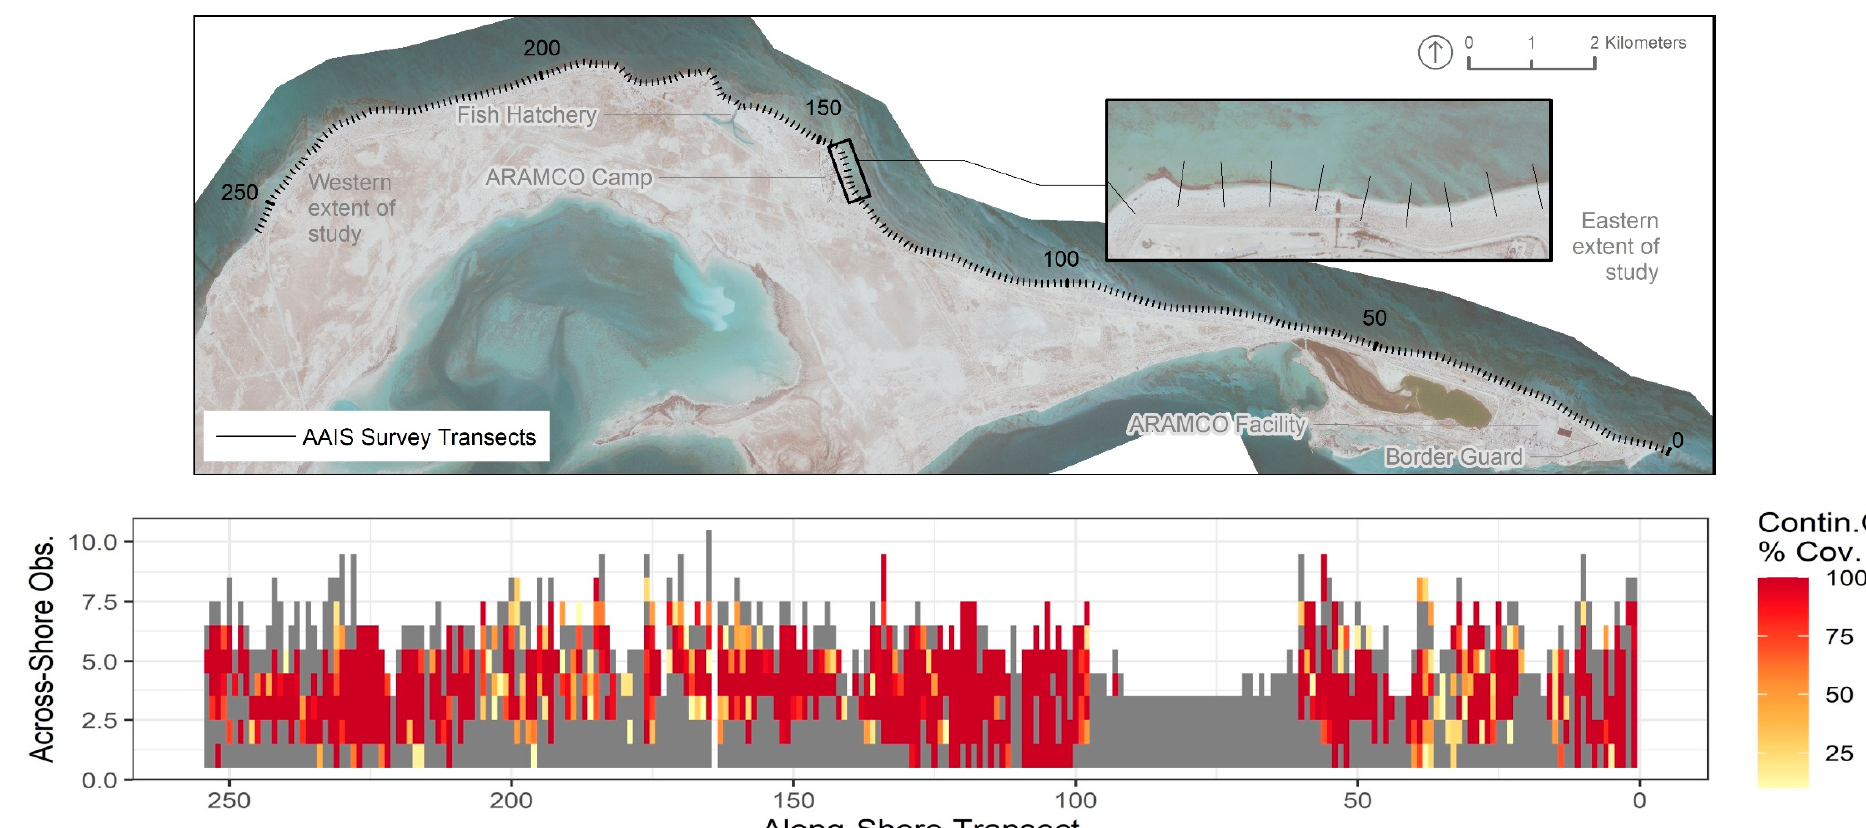
Figure 5. Across-shore tile charts depicting percent cover of continuous asphalt pavements or heavily oiled sediment layers oiling at each observation location. The gray background in the tile charts represents surveyed areas without visible oil.